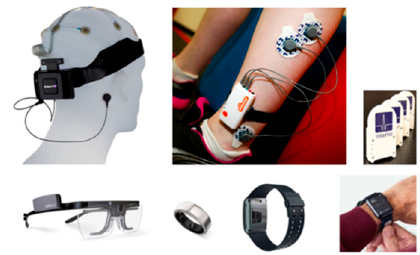
Figure 4. Top from the left: B-Alert X10, Shimmer 3 ECG/EMG/GSR and WideFind UWB-positioning tags. Bottom from the left: Tobii Glasses 2, Oura ring, Empatica E4 and Apple Watch with AliveCor